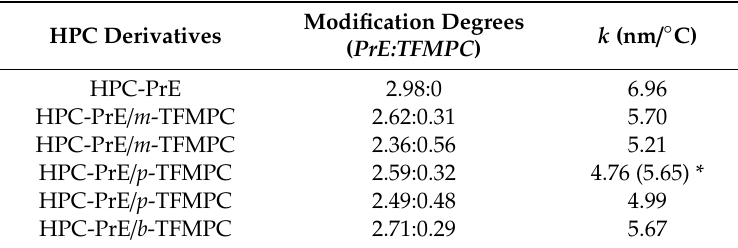
Table 1. The slope coe ffi cient ( k ) values of HPC derivatives in the shifting profiles of reflection peaks as a function of temperature.